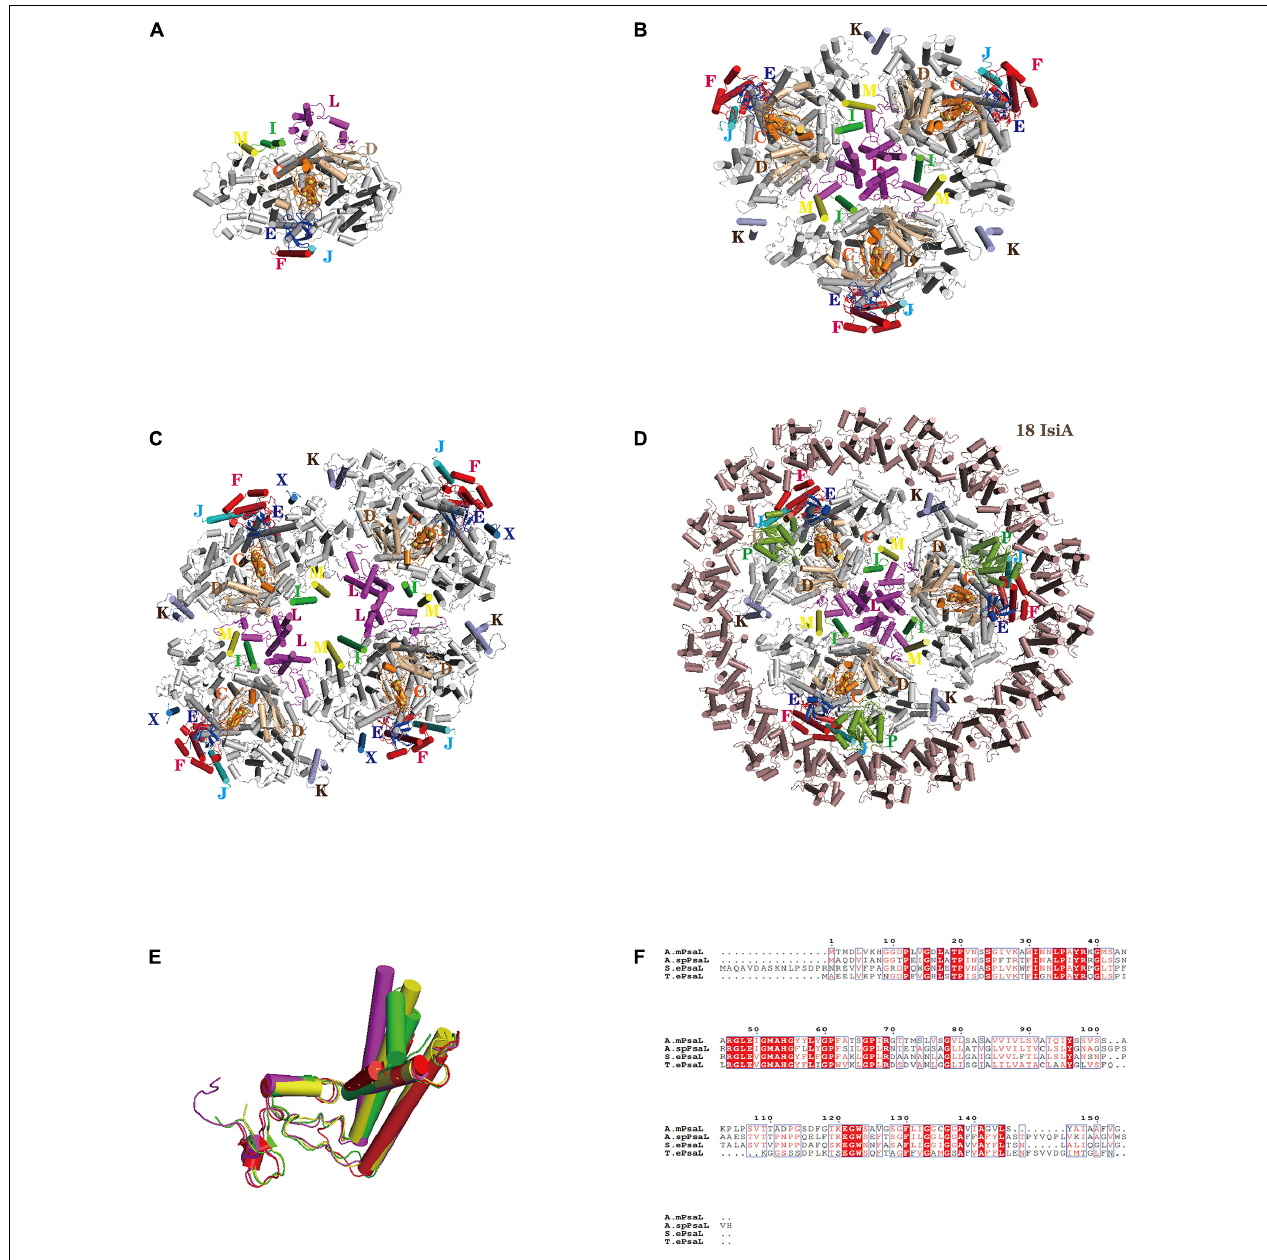
FIGURE 1 | Structures of PSI oligomers from cyanobacteria. (A) PSI core monomer from Thermosynechococcus elongatus (6LU1). (B) Cyanobacterial PSI core trimer (7COY). (C) PSI core tetramer from Anabaena sp. PCC 7120 (6JEO). (D) PSI-IsiA supercomplex from Synechococcus elongatus PCC 7942 (6KIF). (E) Superposition of PsaL from the PSI core monomer in Thermosynechococcus elongatus (6LU1), the PSI core trimer (7COY), the PSI core tetramer in Anabaena sp. PCC 7120 (6JEO), and the PSI-IsiA supercomplex Synechococcus elongatus PCC 7942 (6KIF). (F) Sequence alignment of the PsaL protein from the PSI core monomer, PSI core trimer, PSI core tetramer, and PSI-IsiA supercomplex. The abbreviations used are as follows: A. m.: Acaryochloris marina (cyanobacteria), S. e.: Synechococcus elongatus PCC 7942 (cyanobacteria), T. e.: Thermosynechococcus elongatus (cyanobacteria), A. sp.: Anabaena sp. PCC 7120 (cyanobacteria). Color codes used are as follows (except PsaA and PsaB in panels (A–D) that are not labeled): PsaF, red; PsaI, green; PsaJ, cyan; PsaK, light-blue; PsaL, magenta; PsaM, yellow; PsaE, blue; PsaD, wheat; PsaP, split-pea. Color codes of PsaL in panel (E) : PsaL from Thermosynechococcus elongatus (red); PsaL from Acaryochloris marina (yellow); PsaL from Anabaena sp. PCC 7120 (magenta); PsaL from Synechococcus elongatus PCC 7942